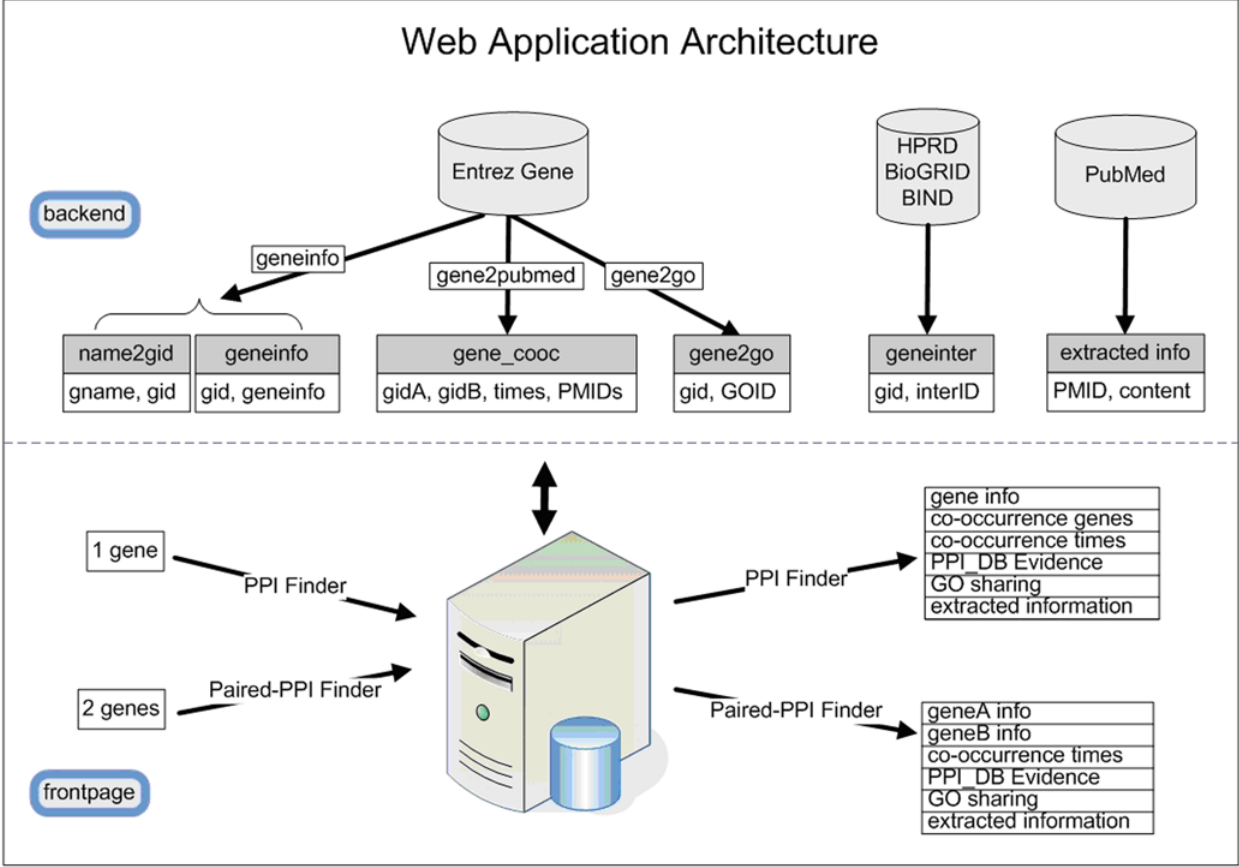
Figure 2. Architecture of the backend and frontpage of PPI Finder. The backend depicts the structure of IR module as shown in figure 1. The frontpage of PPI Finder includes two web applications: PPI Finder (searching one gene at a time) and Paired-PPI Finder (searching two genes at a time). The output format of PPI Finder is summarized.